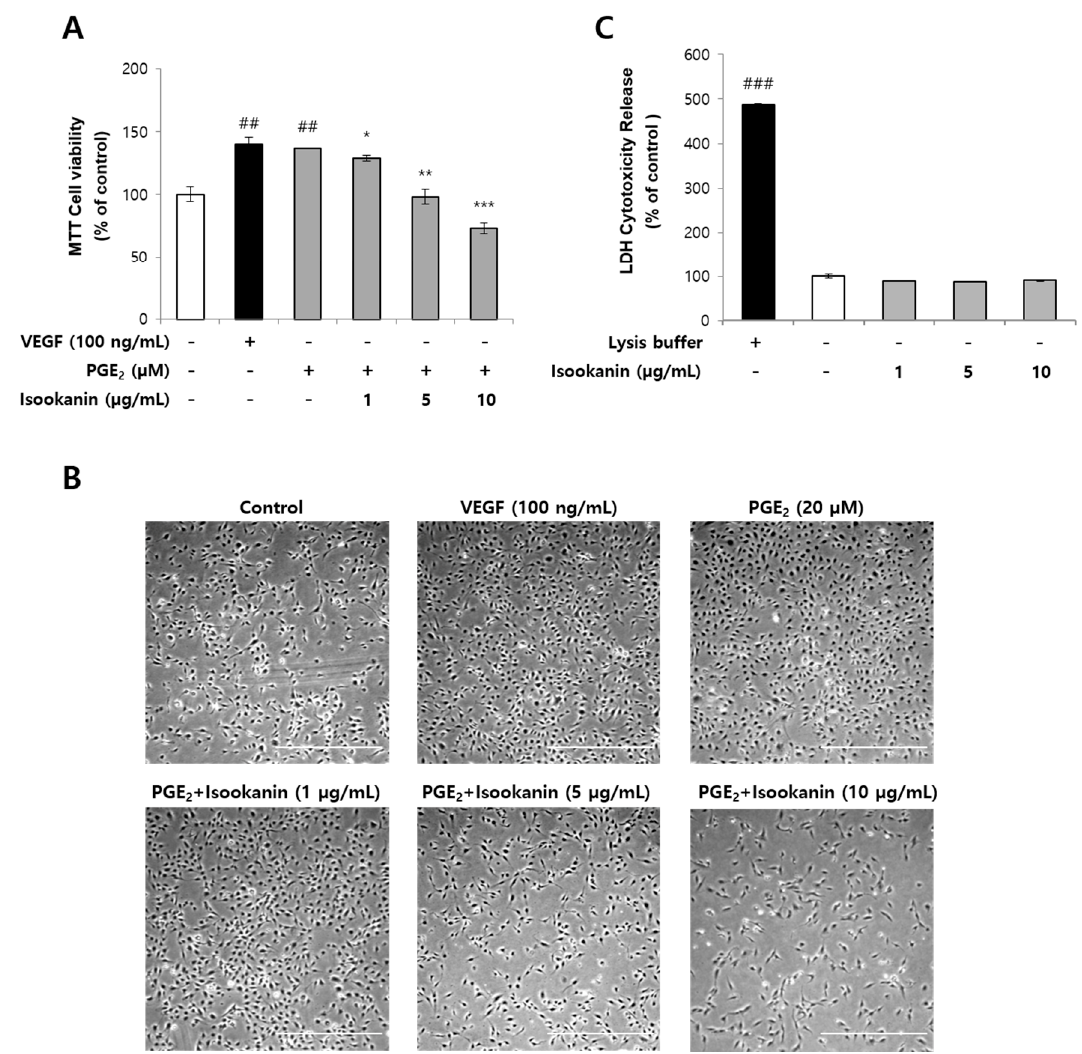
Figure 1. The effect of isookanin on cell proliferation in PGE 2 -induced HMEC-1 cells. Cells were pretreated with the indicated concentrations of isookanin for 2 h before stimulation with PGE 2 (20 µM) or VEGF (100 ng/mL) for 48 h. ( A ) Cell viability was measured using the MTT assay. ( B ) The density of endothelial cells was observed under a microscope; scale bars are 80 µm. ( C ) Cytotoxicity was measured using the lactate dehydrogenase (LDH) cytotoxicity assay. The results are mean ± standard deviation (SD) ( n = 3). ## p < 0.01, ### p < 0.001 vs. control. * p < 0.05, ** p < 0.01, and *** p < 0.001 vs. PGE 2 -treated control.